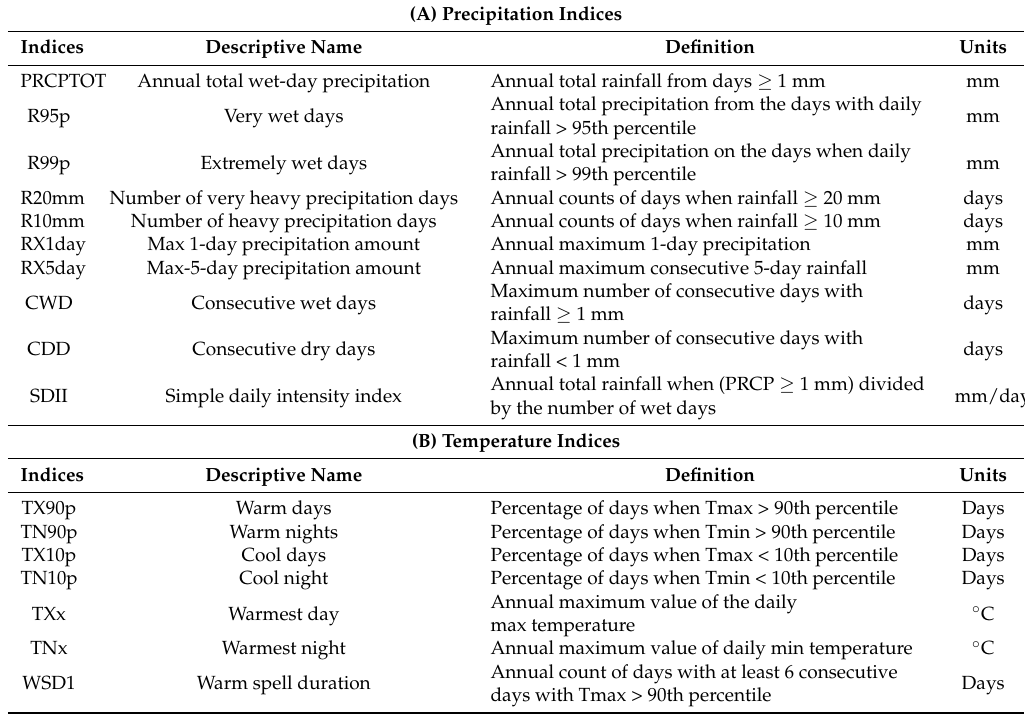
Table 3. Climate Extreme